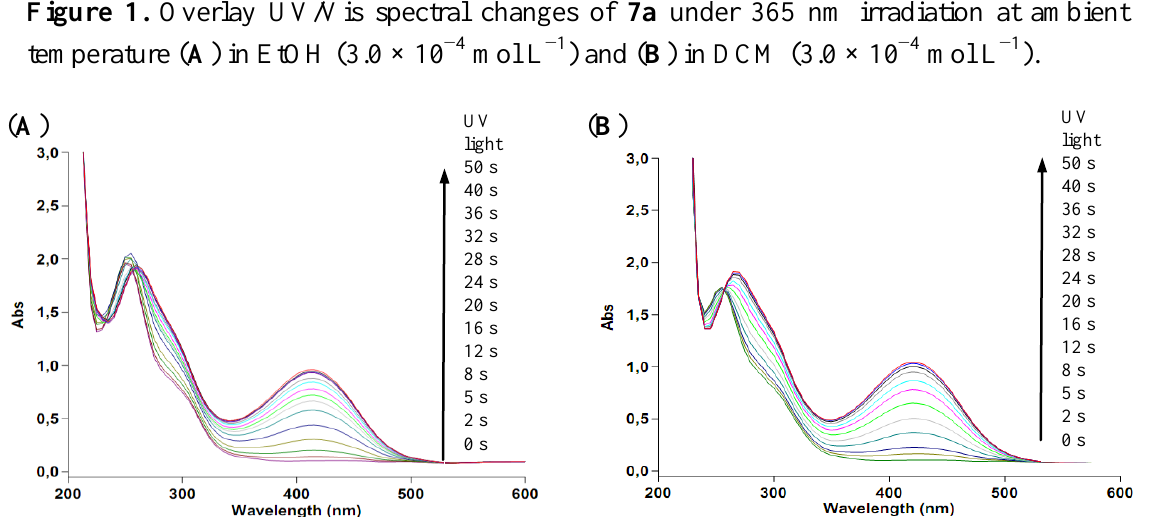
Figure 1. Overlay UV/Vis spectral changes of 7a under 365 nm irradiation at